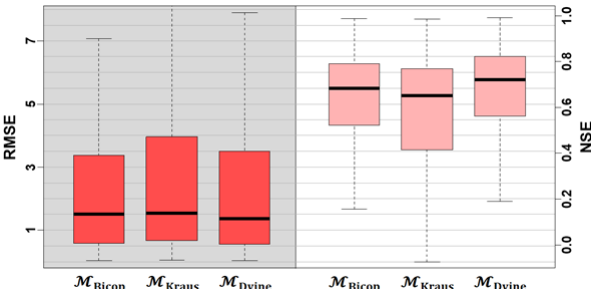
Figure 5. Model performance for the Yadkin–Pee Dee river under a cross-validation framework, based on RMSE (dark squares) and NSE (light squares). Here, the RMSE (NSE) can range from 0 to ∞ ( −∞ to 1), with lower RMSE (higher NSE) implying better perfor-